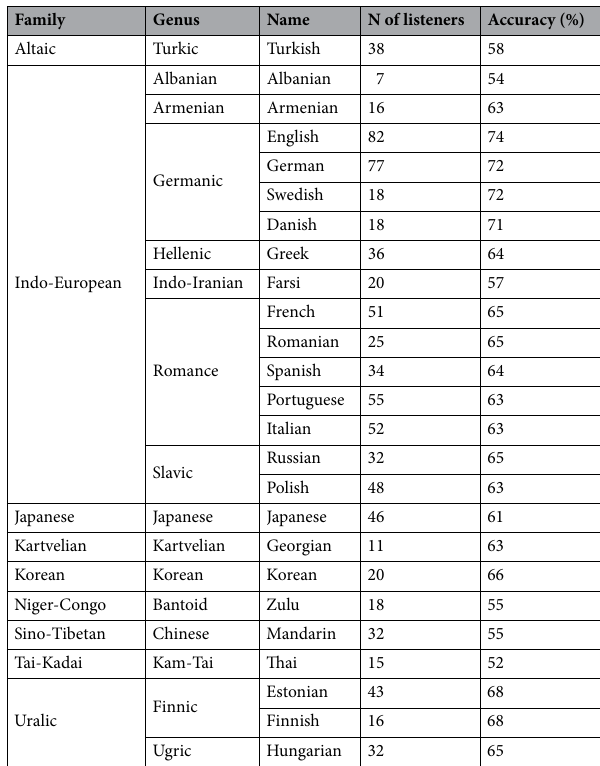
Table 3. Number of listeners and average accuracy (descriptive averages, chance = 16.7%) for each language in the sample for the online experiment in alphabetical order by language family and genus. Within a genus, the languages are sorted by the accuracy (see Fig. 2 for complementary posterior estimates and 95% credible intervals from the main